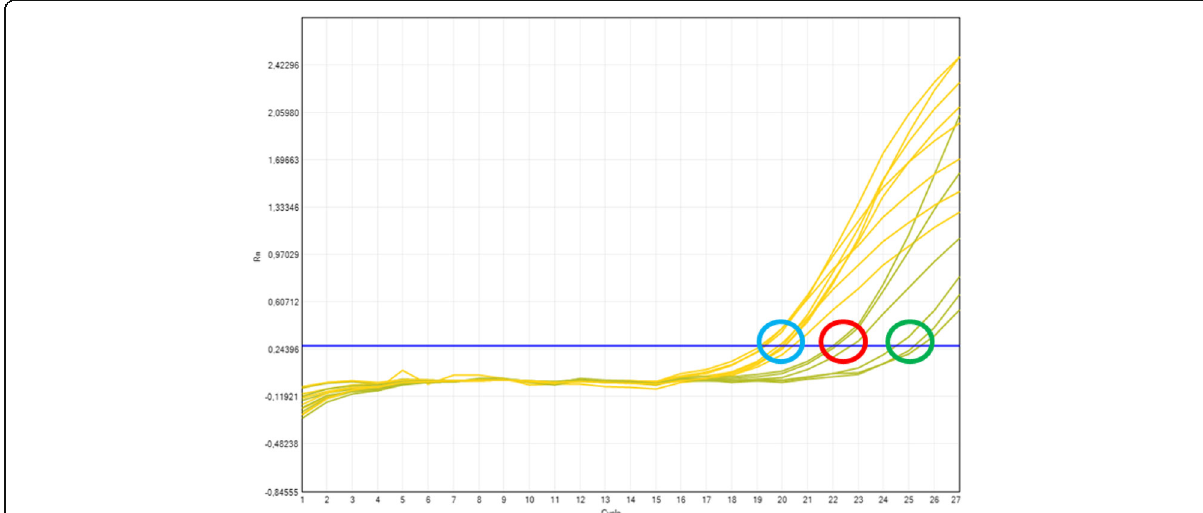
Fig. 2 Behavior of carrier samples in the allele specific multiplex-PCR scanning 14 CFTR gene mutations. Wild type ( yellow ) and mutant ( green ) curves of samples carrying one mutation ( green circle) or two mutations ( red circle). The blue circle points out the Ct zone of the wild type